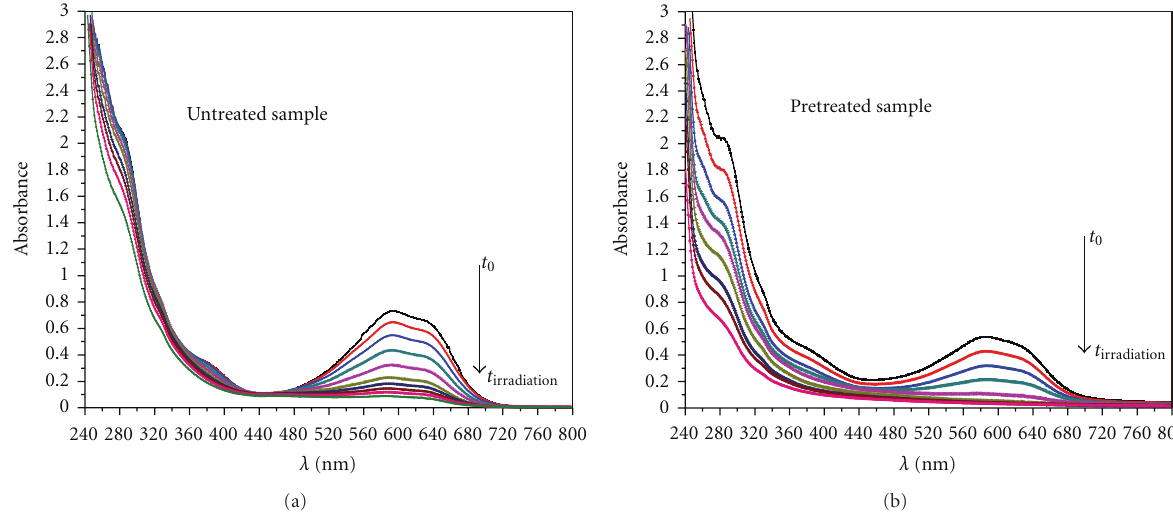
Figure 3: UV-Vis spectral changes as function of time of irradiation of untreated (a) and pretreated (b) Reactive Blue 19 textile e ffl uent taken 5 to 15 min intervals, the irradiation time was 90 min.